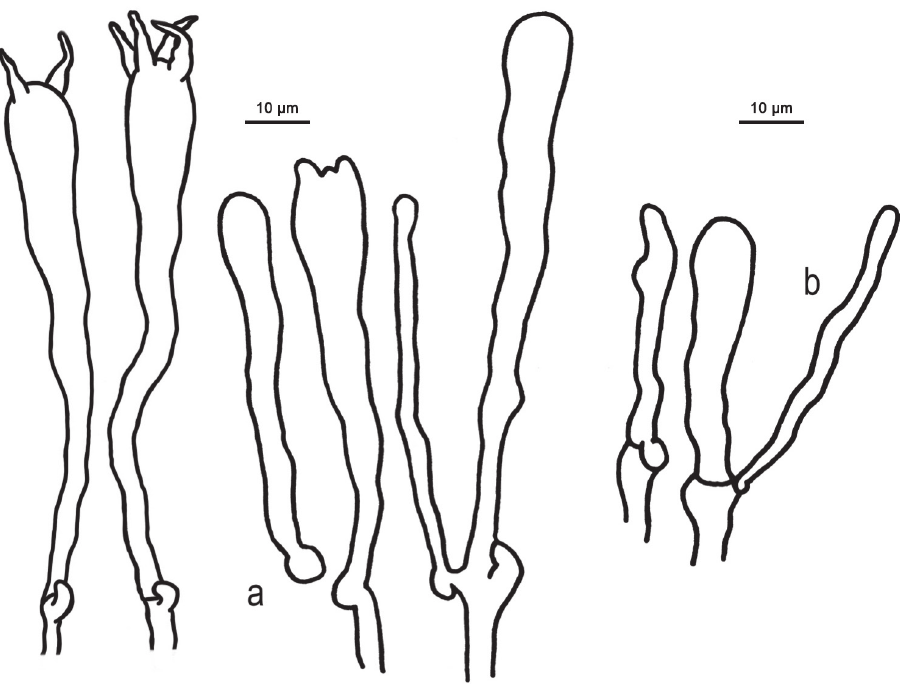
Figure 13. Microscopic features of Clavariadelphus sachalinensis (MHHNU 7816). a Basidia b Lepto- cystidia and immature